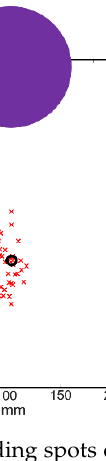
Figure 8. Experimental setup of the autonomous landing system. ( a ) Configuration of the landing experiments with arrows at each location showing the direction where the MAV is facing; ( b ) platform and MAV at the start of the autonomous landing control.